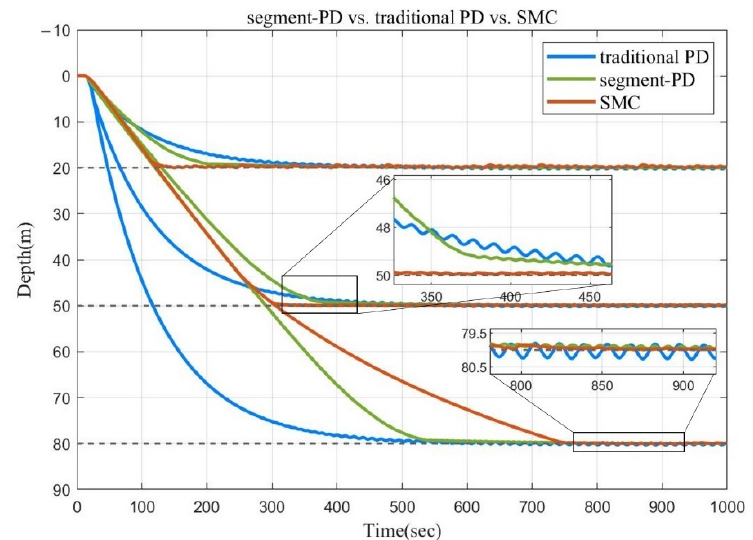
Figure 4. Control performance of the three depth control methods at the target depths of 20 m, 50 m, and 80 m.